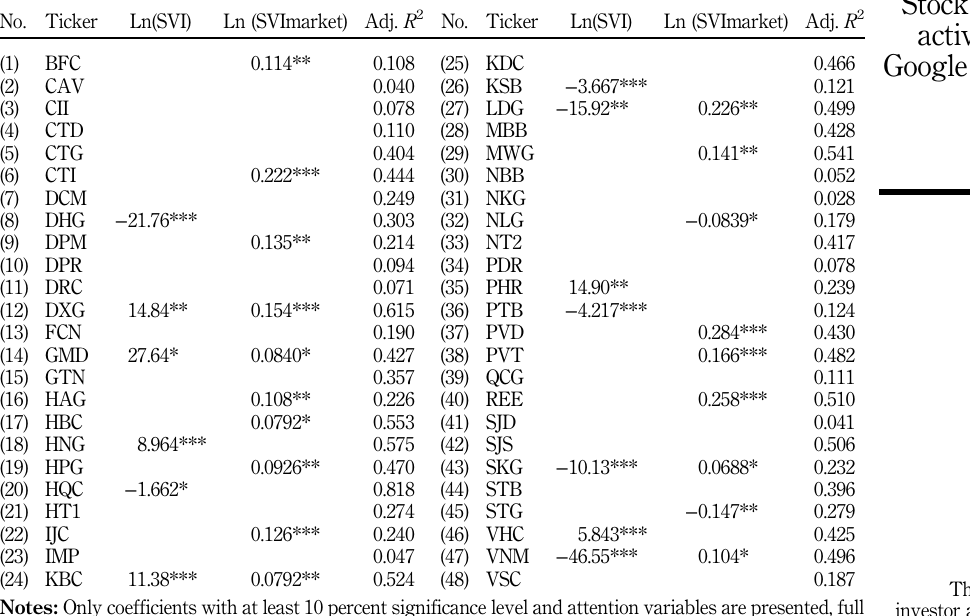
Table V. The impact of investor attention on stock